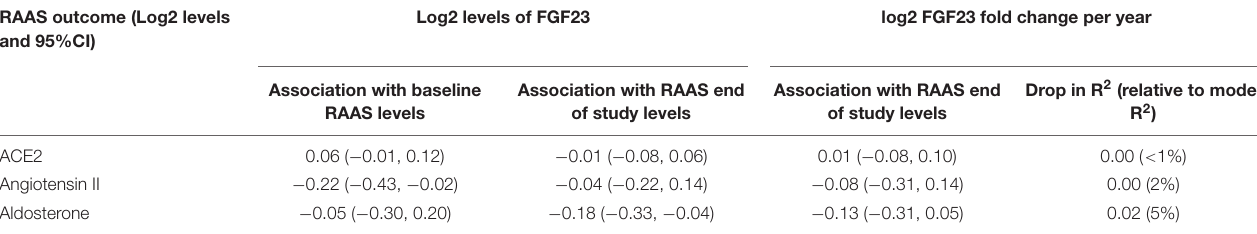
TABLE 3 | Association between FGF23 and RAAS parameters. RAAS outcome (Log2 levels and